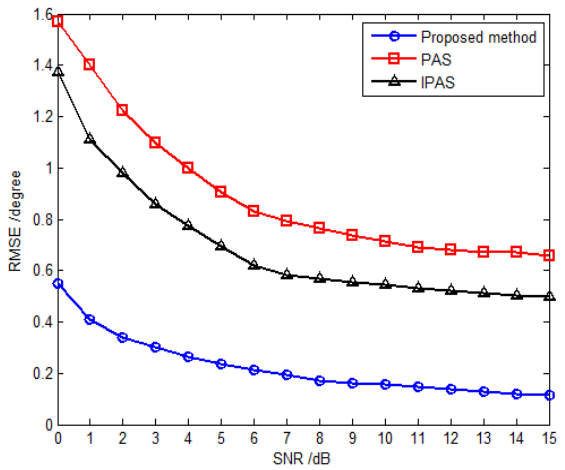
Figure 6. RMSE versus SNR for uncorrelated sources with fixed snapshot number 500.